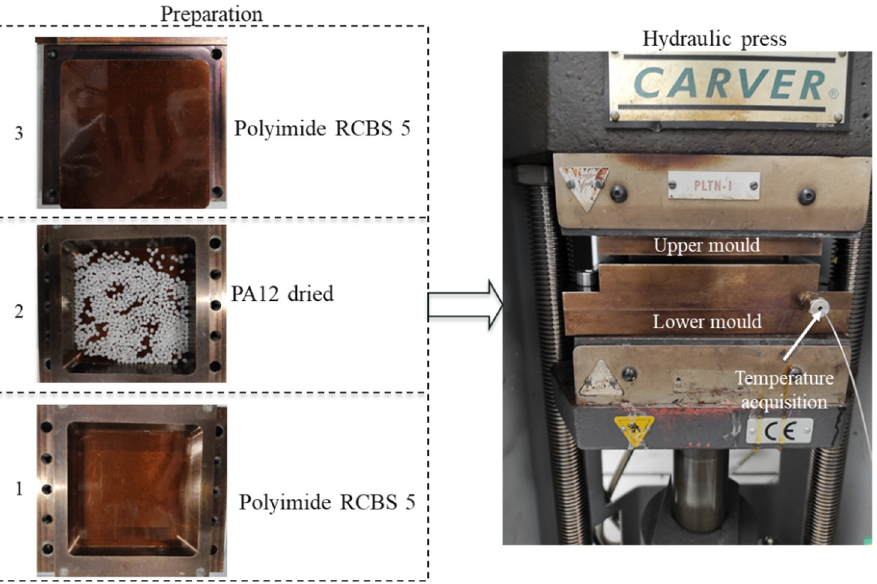
Figure 2. Preparation of PA12 sheet. 1- the lower mold covered by polyimide RCBS 5, 2- 12 g dried PA12, 3- upper mold covered by polyimide RCBS 5.